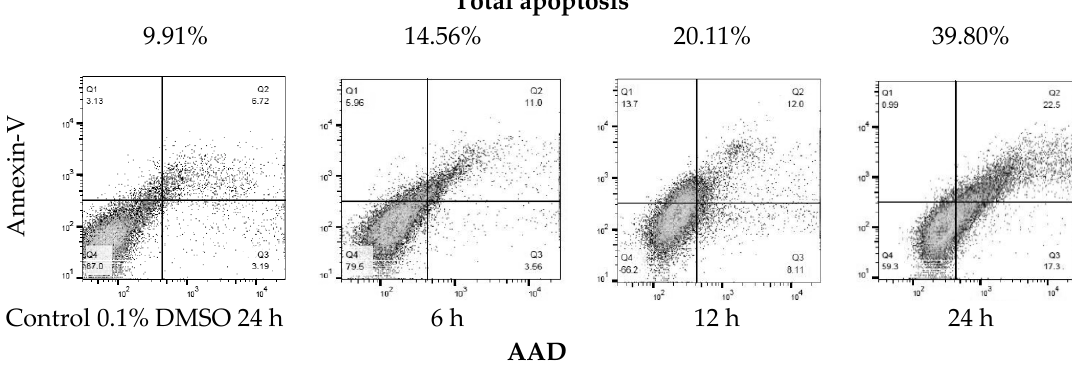
Figure 2. Translocation of phosphatidylserine by flow cytometry (Annexin V-FITC/7-AAD staining). Representative plots of SK-LU-1 cells cultured in the presence fractioned extract of A. lechuguilla with an IC 50 = 6.96 µg/mL, are shown (total apoptosis-time of exposure).